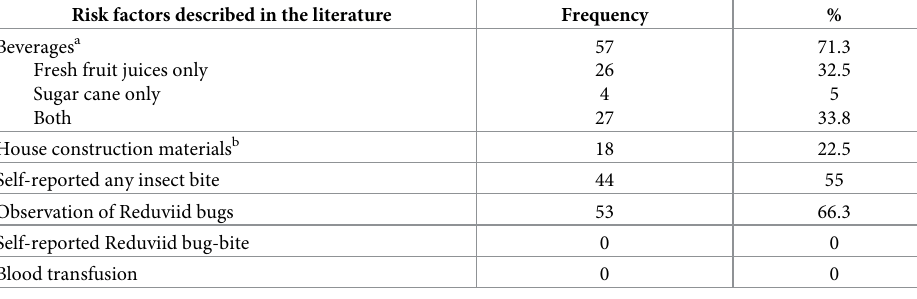
Table 2. Exposure to well described risk factors for T . cruzi infection (n =